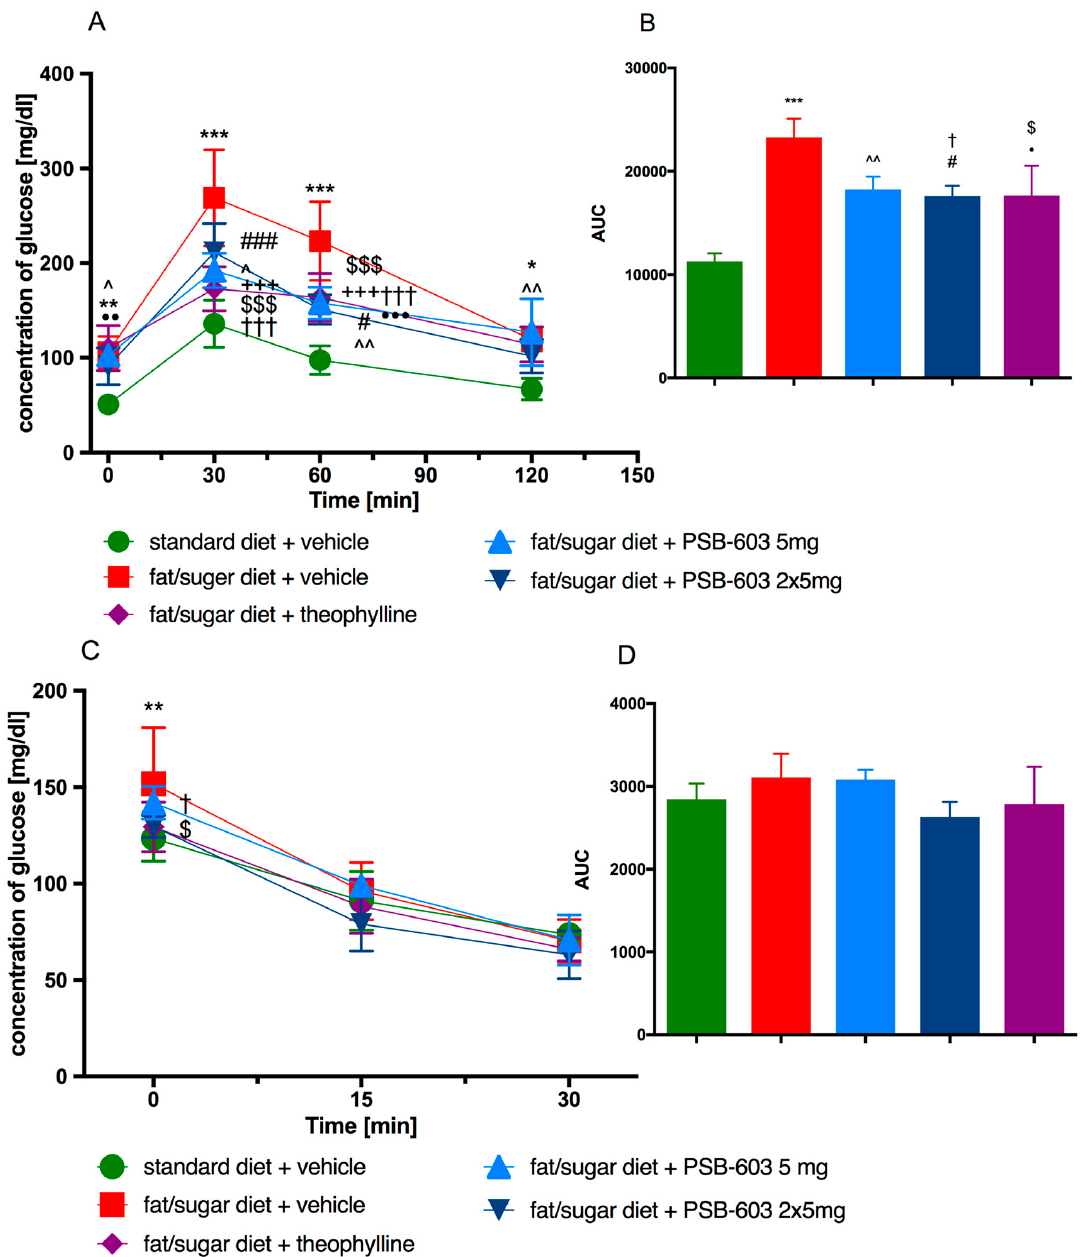
Figure 7. Intraperitoneal glucose tolerance test (IPGTT) ( A ). The area under the IPGTT curve ( B ). Insulin sensitivity test (IST) ( C ). The area under the IST curve ( D ). Results are expressed as means ± SD, n = 6–9. Comparisons were made by two-way ANOVA, Bonferroni post hoc; * significant between control mice fed a standard diet and control mice fed a fat/sugar diet; ˆ significant between control mice fed a standard diet and mice treated with PSB-603 at a dose of 5 mg/kg b.w./day and fed a fat/sugar diet; # significant between control mice fed a standard diet and mice treated with PSB-603 at a dose of 2 × 5 mg/kg b.w./day and fed a fat/sugar diet; • significant between control mice fed a standard diet and mice treated with theophylline at a dose of 2 × 50 mg/kg b.w./day and fed a fat/sugar diet; + significant between control mice fed a fat/sugar diet and mice treated with PSB-603 at a dose of 5 mg/kg b.w./day and fed a fat/sugar diet; † significant between control mice fed a fat/sugar diet and mice treated with PSB-603 at a dose of 2 × 5 mg/kg b.w./day and fed a fat/sugar diet; $ significant between control mice fed a fat/sugar diet and mice treated with theophylline at a dose of 2 × 50 mg/kg b.w./day and fed a fat/sugar diet; *, #, ˆ, $, †, • p < 0.05, **, •• , ˆˆ p < 0.01, ***, +++, †††, ••• , ###, $$$ p <